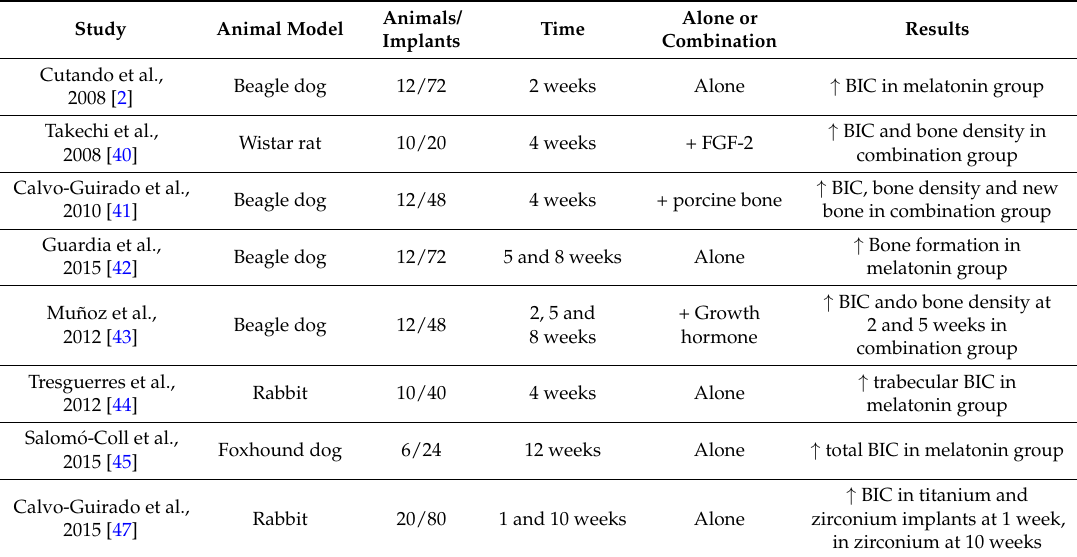
Table 1. Summary of studies focusing on the use of melatonin in dental implants